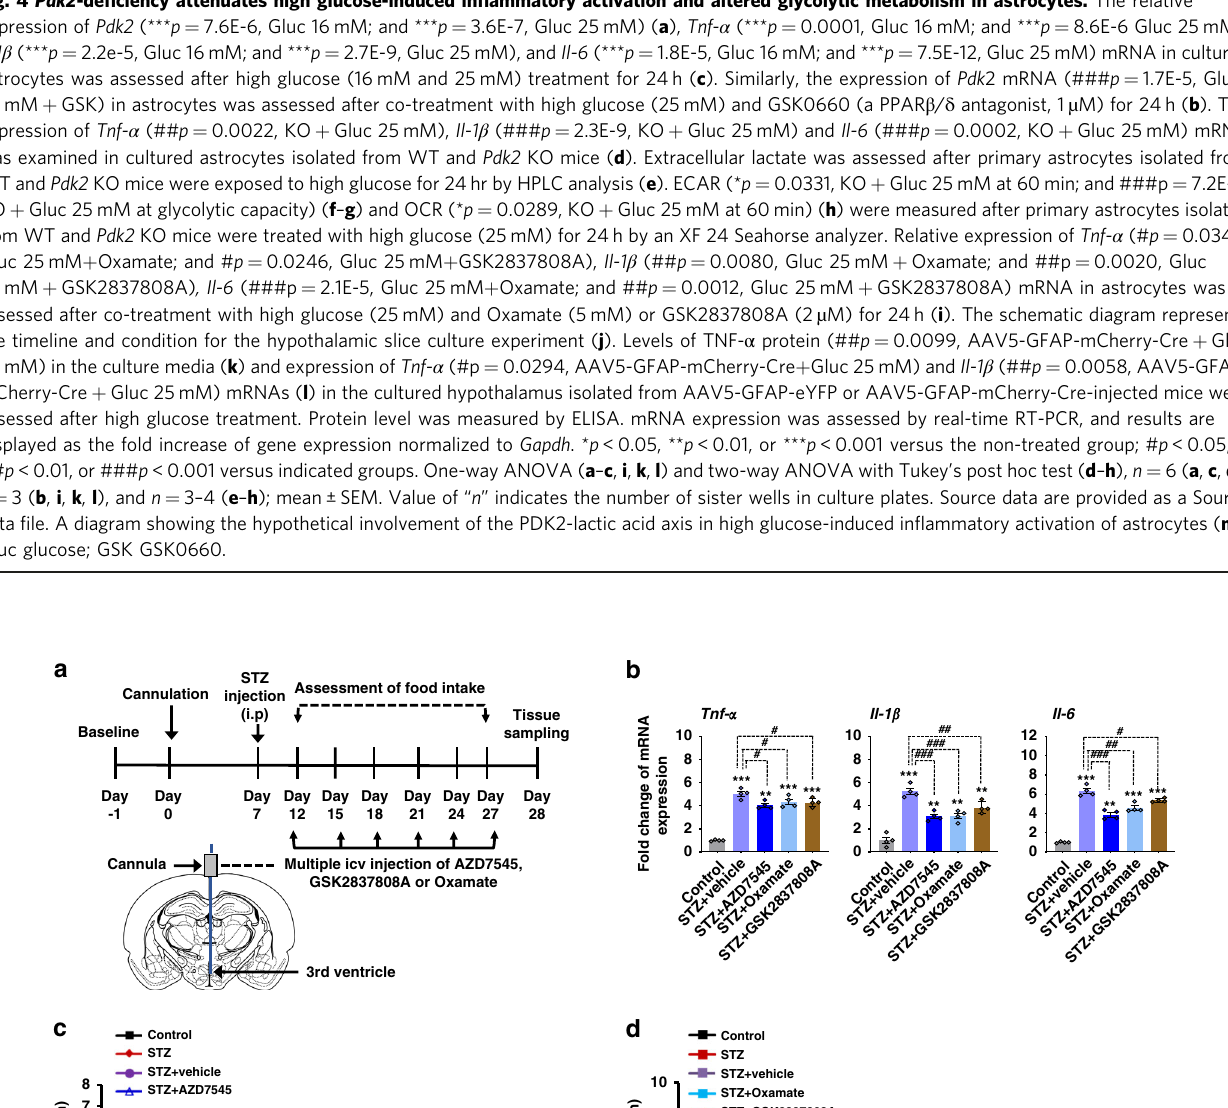
Fig. 4 Pdk2 -de fi ciency attenuates high glucose-induced in fl ammatory activation and altered glycolytic metabolism in astrocytes. The relative expression of Pdk2 (*** p = 7.6E-6, Gluc 16 mM; and *** p = 3.6E-7, Gluc 25 mM) ( a ), Tnf- α (*** p = 0.0001, Gluc 16 mM; and *** p = 8.6E-6 Gluc 25 mM),